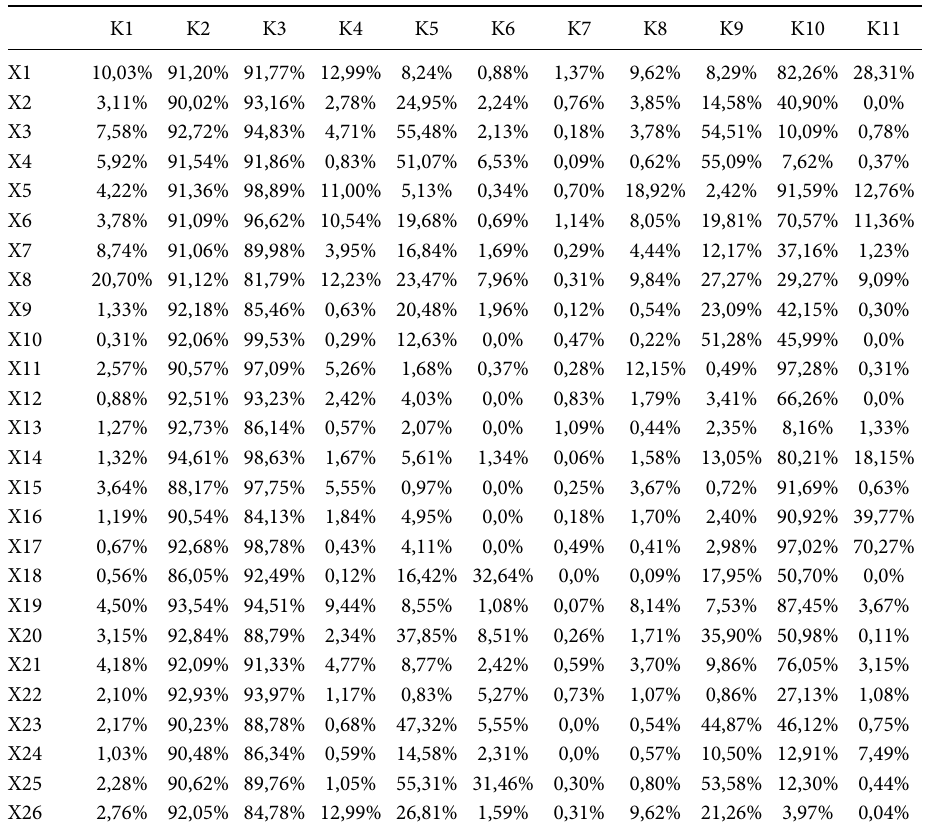
Table A2. Evaluation